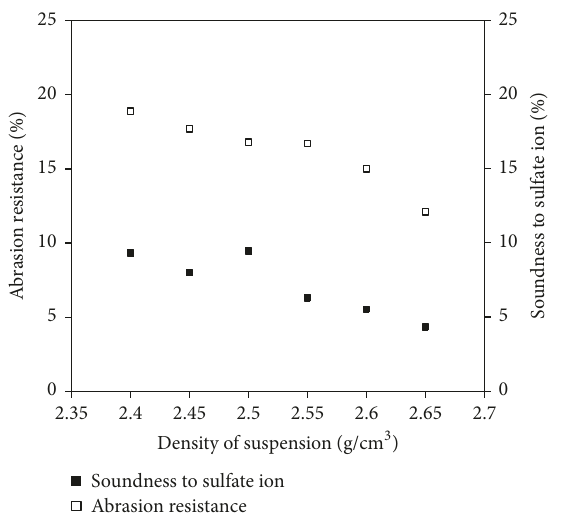
Figure 10: Variation of sink rate with changing the density of the Fe 3 O 4 suspension from 2.4 to 2.65 g/cm 3 .